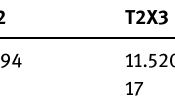
Table 6: The ILSS between carbon fi ber mat and epoxy resin